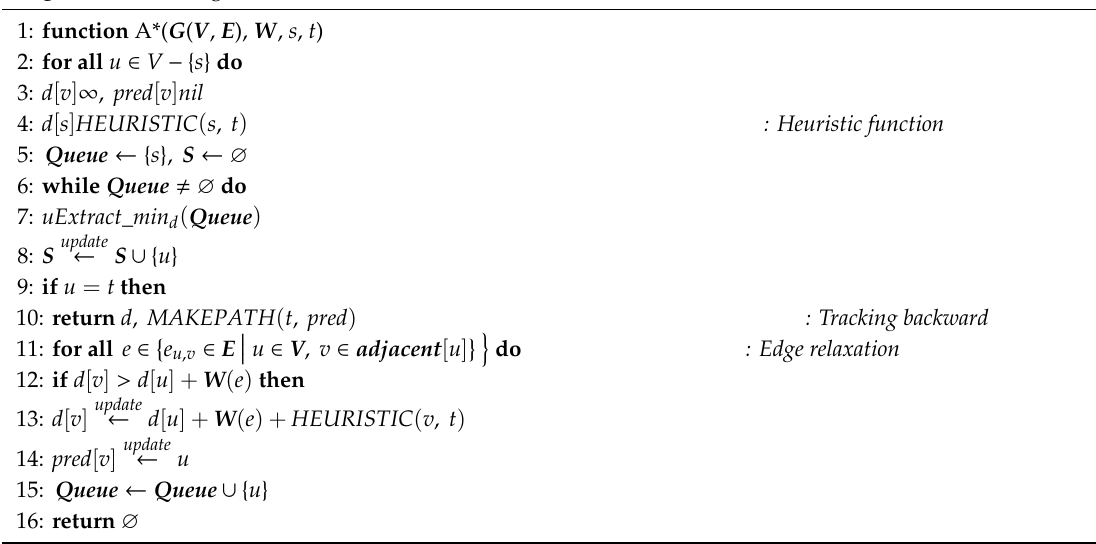
Algorithm 3. A* Algorithm